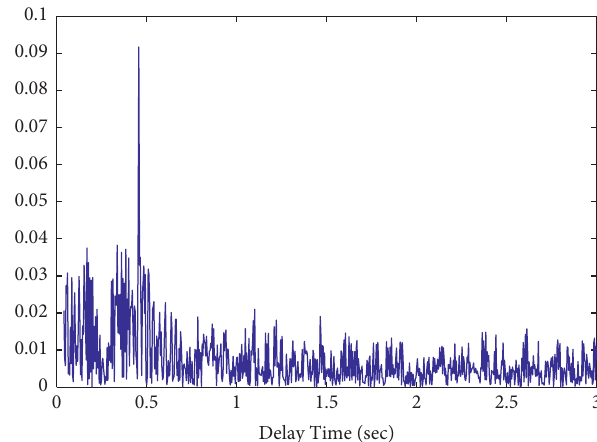
Figure 8: Delay time of the underwater explosion on December 1, 2017, recorded by H10N1.